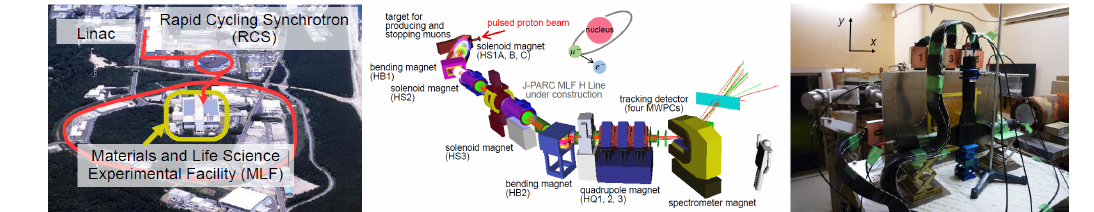
Figure 3: Photograph of one of the four multi- wire proportional cham- bers (MWPCs).